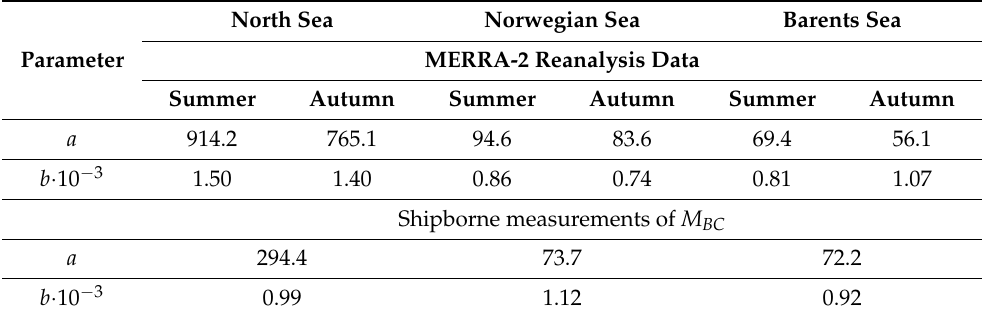
Table 4. Parameters of exponential approximation of the dependence M BC ( L ) in three sea areas. North Sea Norwegian Sea Barents Sea Parameter MERRA-2 Reanalysis Data Summer Autumn Summer Autumn Summer